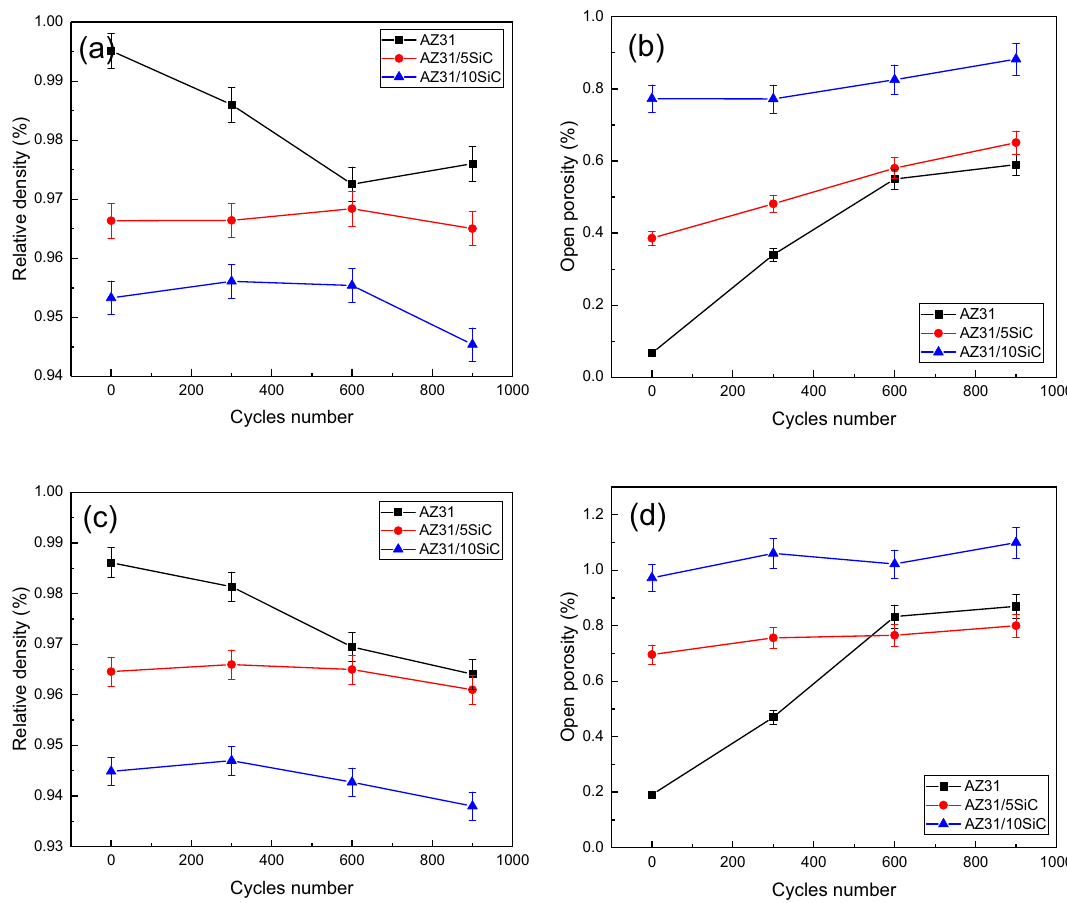
Figure 13. ( a ) Relative density of as-cast samples after thermal cycles at 150 °C, ( b ) open porosity of as-cast samples after thermal cycles at 150 °C, ( c ) relative density of as-cast samples after thermal cycles at 350 °C, and ( d ) open porosity of as-cast samples after thermal cycles at 350